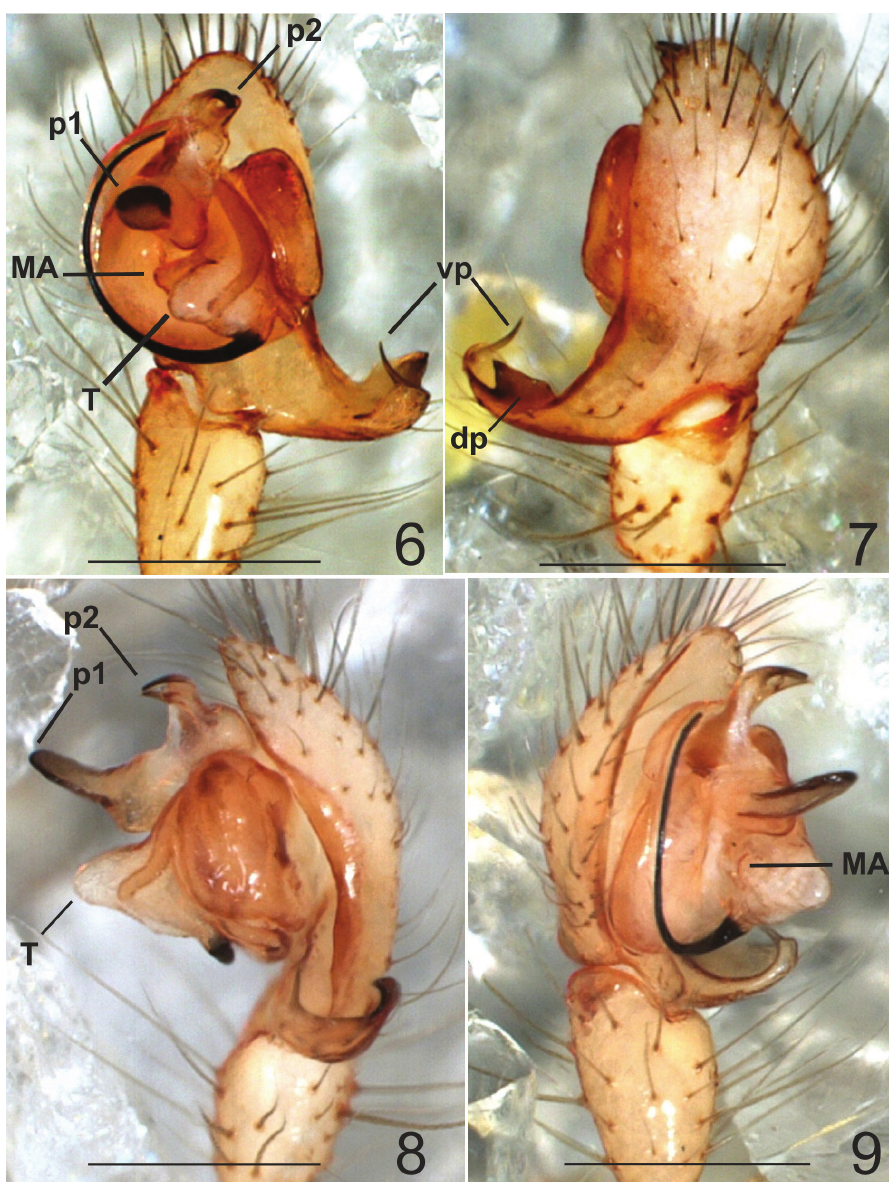
Figures 6–9. Typhlonesticus gocmeni sp. n. male palp. 6 ventral view 7 dorsal view 8 retrolateral view 9 pro- lateral view. Abbreviations: T = tegulum, MA = median apophysis, p1 = process 1 of TTA, p2 = process 2 of TTA, vp = ventral process of paracymbium, dp = dorsal process of paracymbium. Scale bars 0.5 mm. truncated sequence lengths. Uncorrected cox1 genetic divergences among terminal taxa, and uncorrected genetic cox1 divergences within and between the analyzed gen- era are summarized in Appendices 3 and